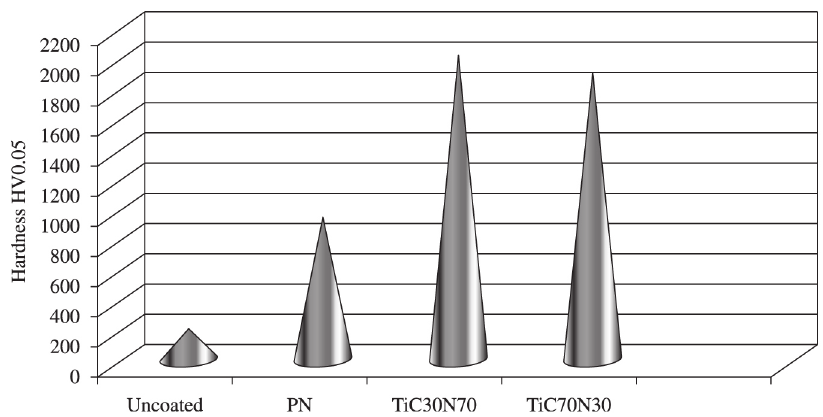
Figure 6. hardness values of TiCN coatings in various flow